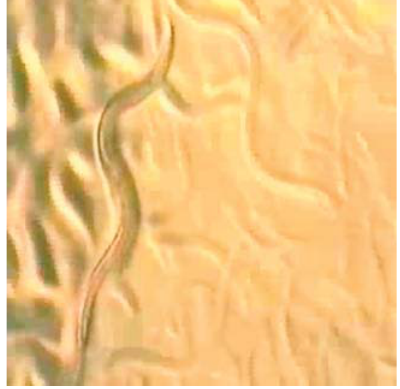
Video 1. Normal Nematodes at Day 1 of Adulthood (Video used by permission from Cynthia